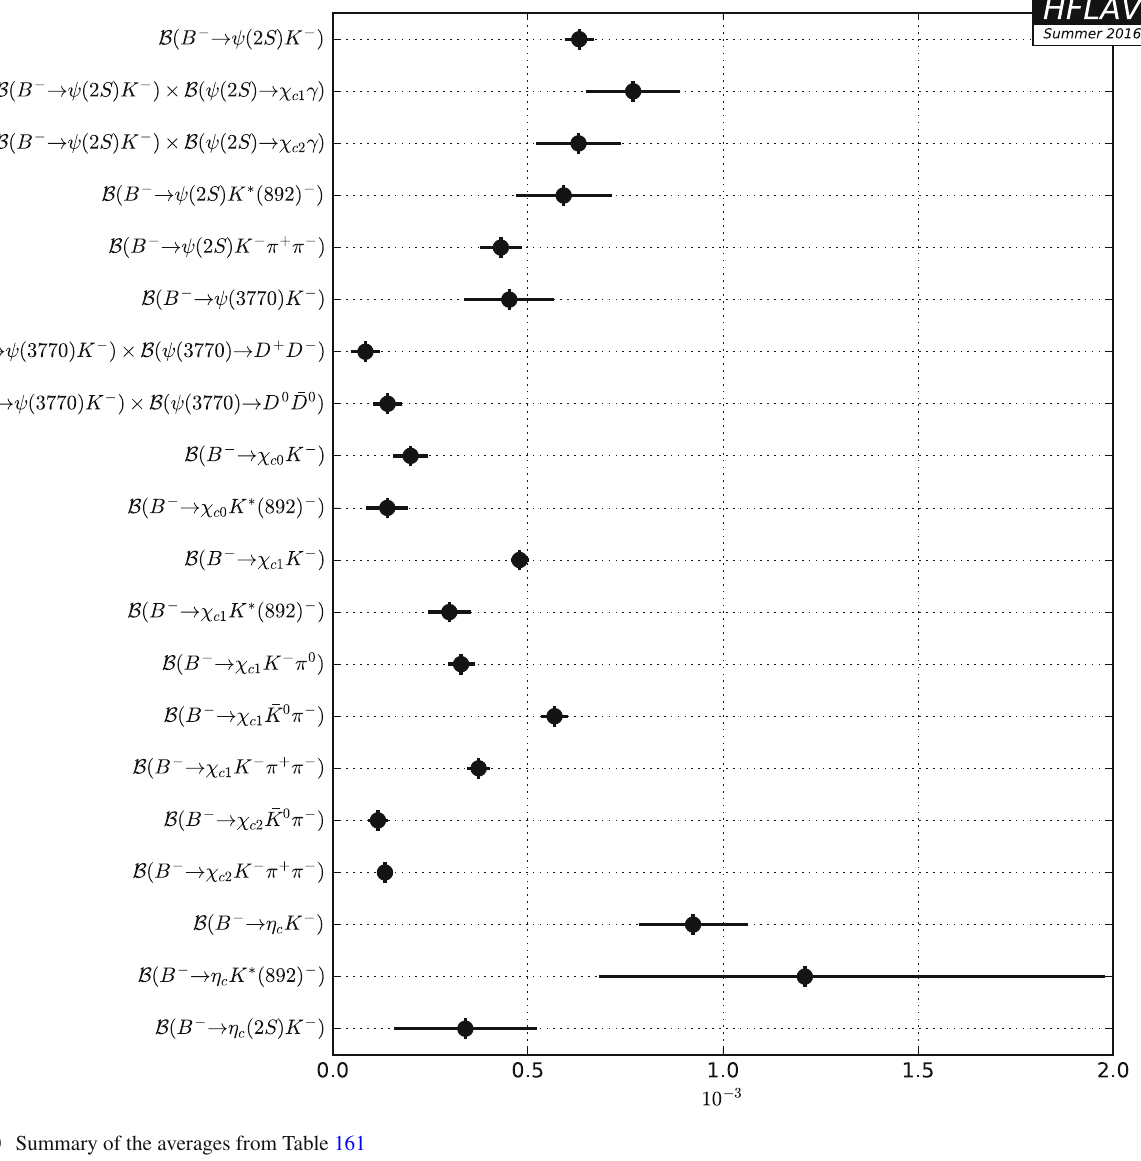
Fig. 130 Summary of the averages from Table 161